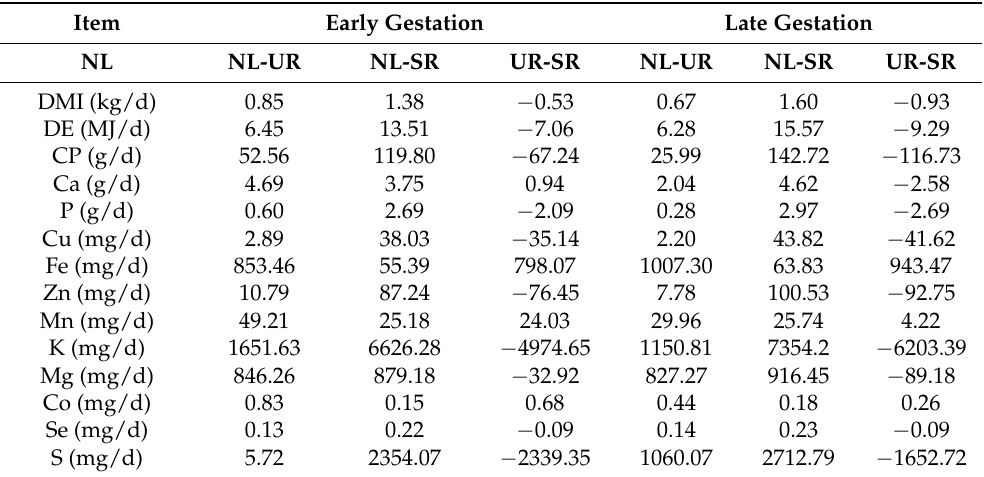
Figure 2. Forage intake proportion of cashmere goats in late gestation (%). Table 3. Nutrition surplus and deficit of cashmere goats during gestation under grazing conditions (dry matter